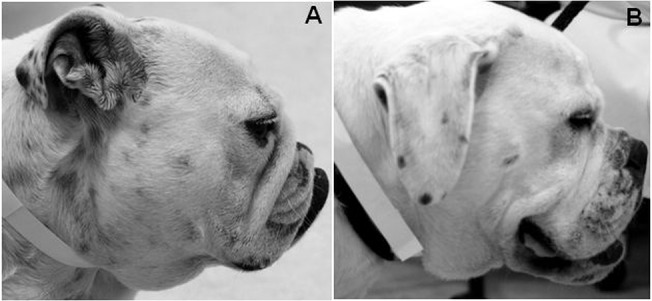
Example of dogs with and without nasal folds.A Bulldog with a marked nasal fold obscuring the nasal planum (A), and a relatively longer muzzled American Bulldog lacking this feature (B).